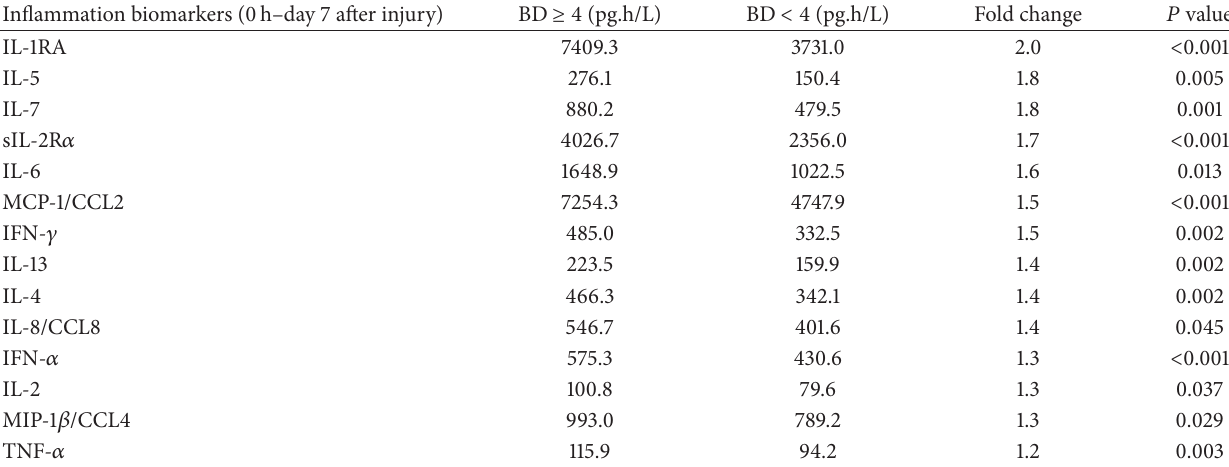
Table 3: Summary of the area under the curve (AUC) analysis from the time of injury up to day 7 for statistically significantly different inflammatory mediators (by two-way ANOVA) between the BD < 4 and the BD ≥ 4 subgroups. Inflammation biomarkers (0h–day 7 after injury) BD ≥ 4 (pg.h/L) BD < 4